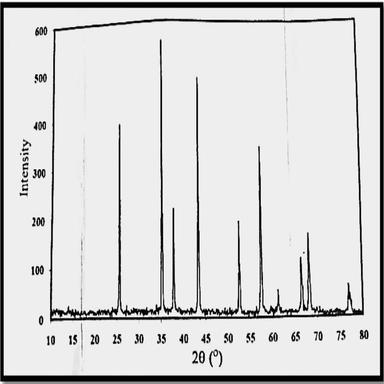
XRD Analysis of aluminum oxide nanoparticles.